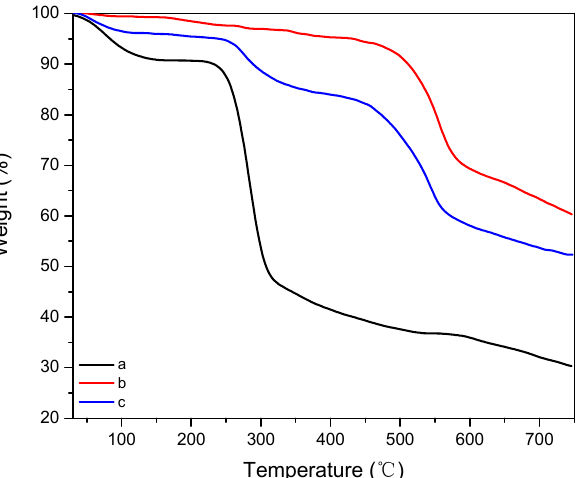
Figure 6. TGA spectra of (a) CCNF/ANF-0 sample, (b) pure ANF porous sample, and (c) CCNF/ANF-1 sample.